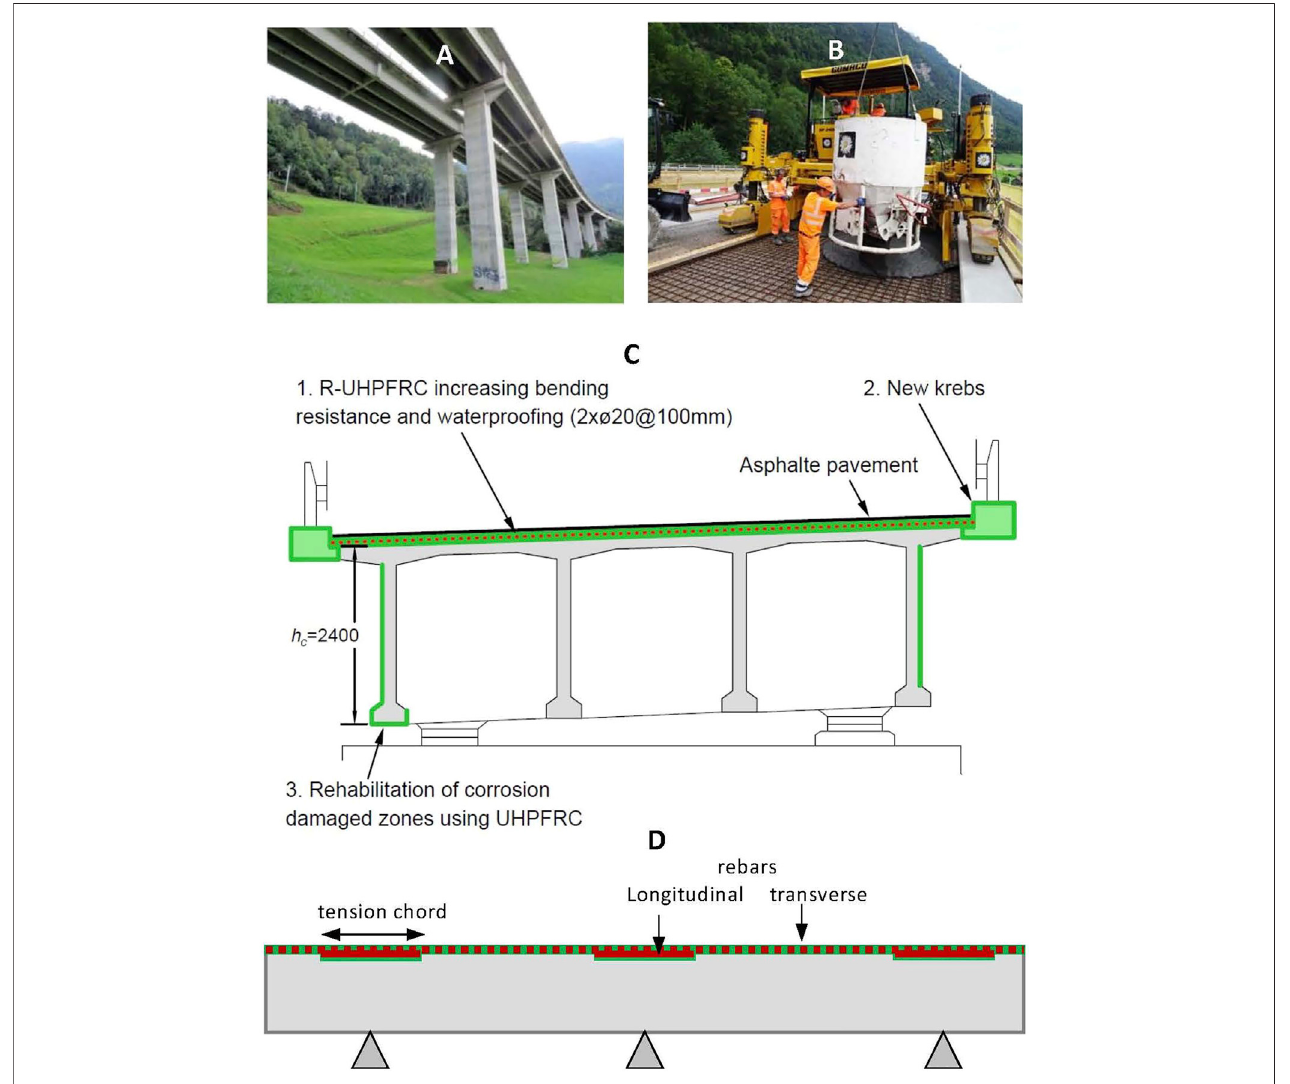
FIGURE 10 | Rehabilitation of the Arth-Goldnau Viaducts. (A) Photograph the fi rst twin viaducts (Photograph: E. Brühwiler), (B) UHPFRC casting (Photograph: A. Weykeystone), (C) , (D) schemes of the interventions.